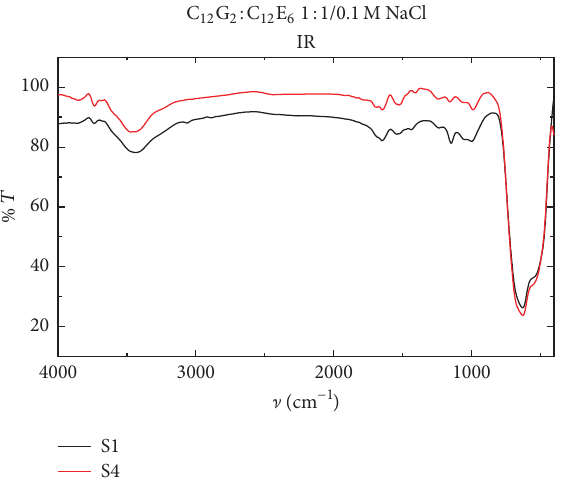
Figure 1: The characteristic IR spectra for the representatives synthesized compounds by grafting phosphonic acids on the SnO 2 .